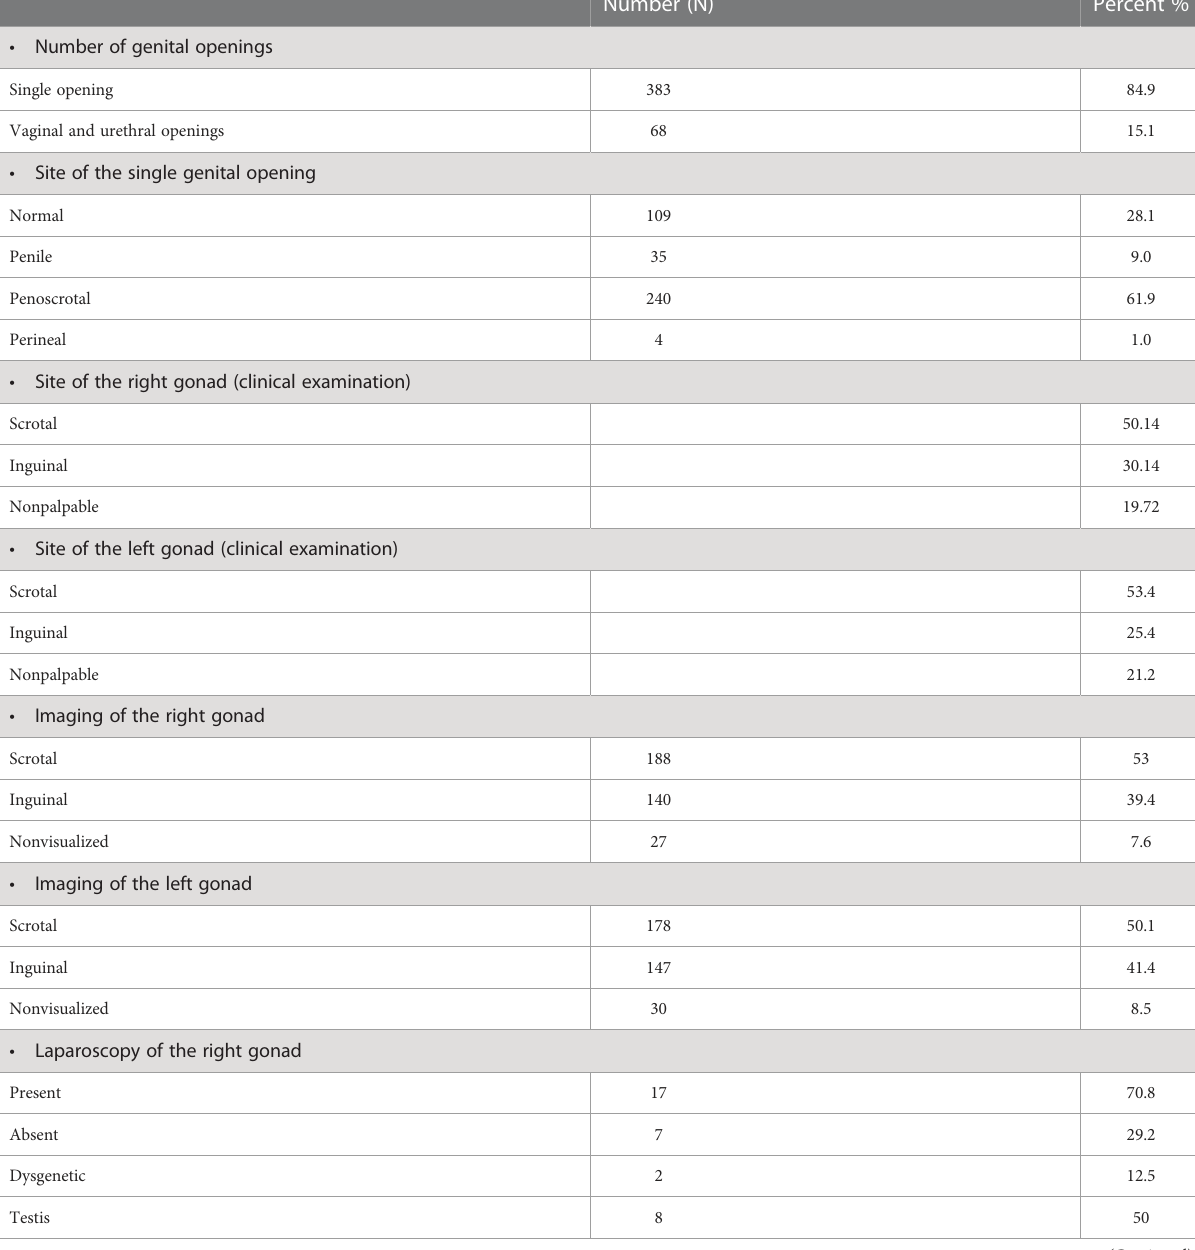
TABLE 1 Clinical criteria, imaging, and laparoscopic fi ndings of patients with